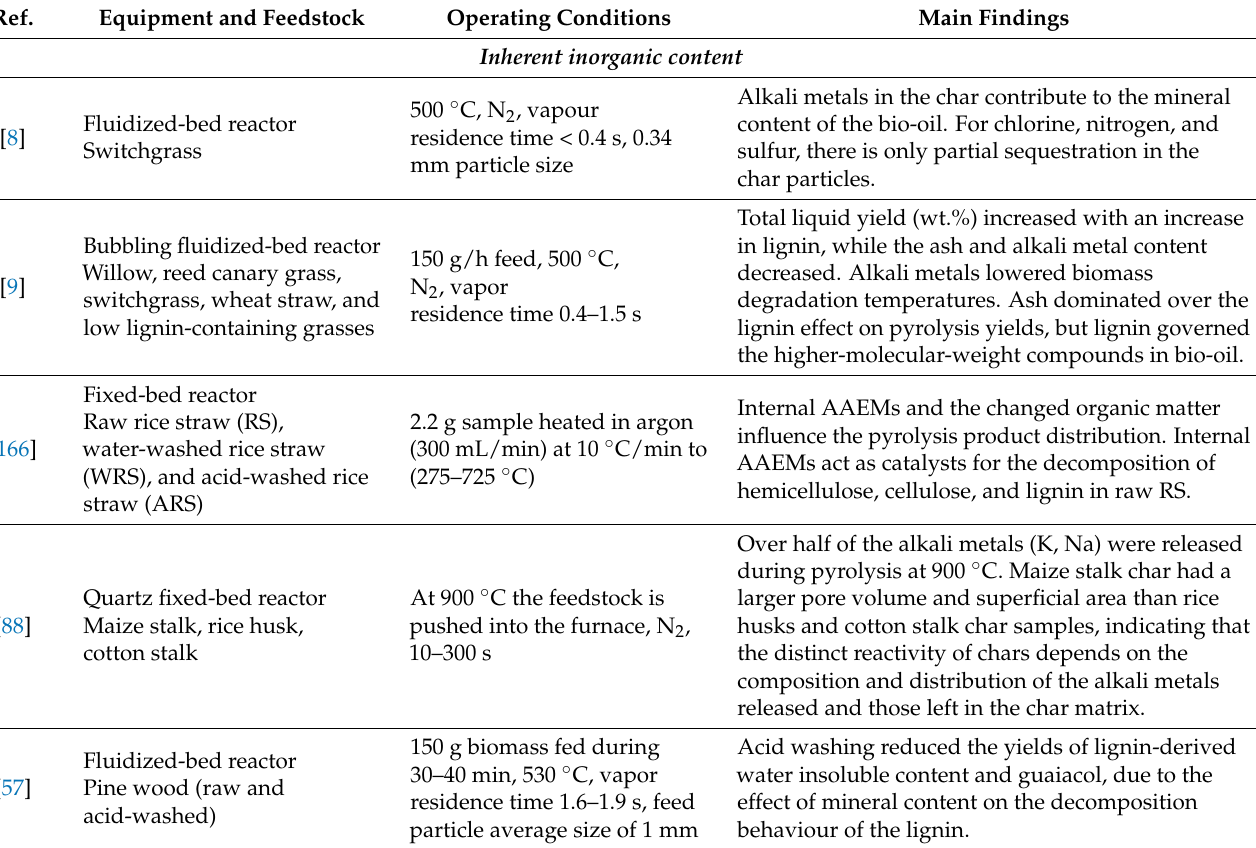
Table A3. Experimental studies investigating the effects of inorganic content on the pyrolysis of raw and washed